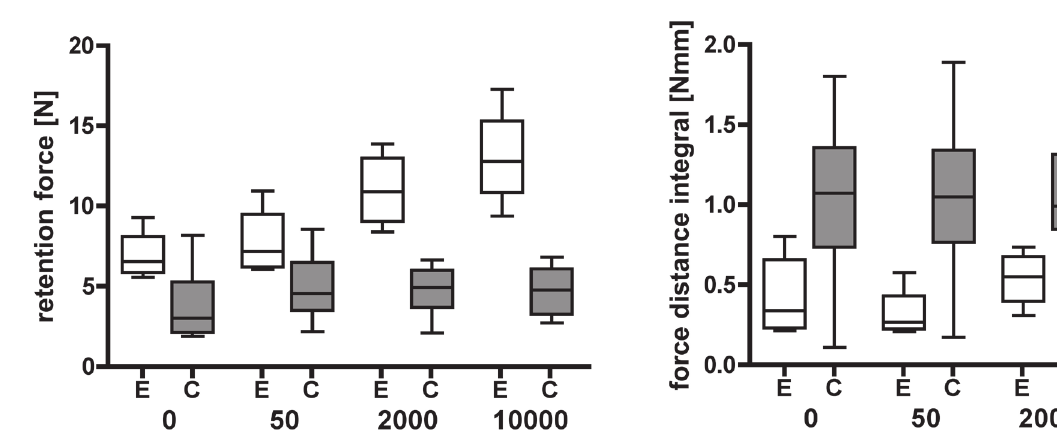
E=electroplated female part, C=cast female